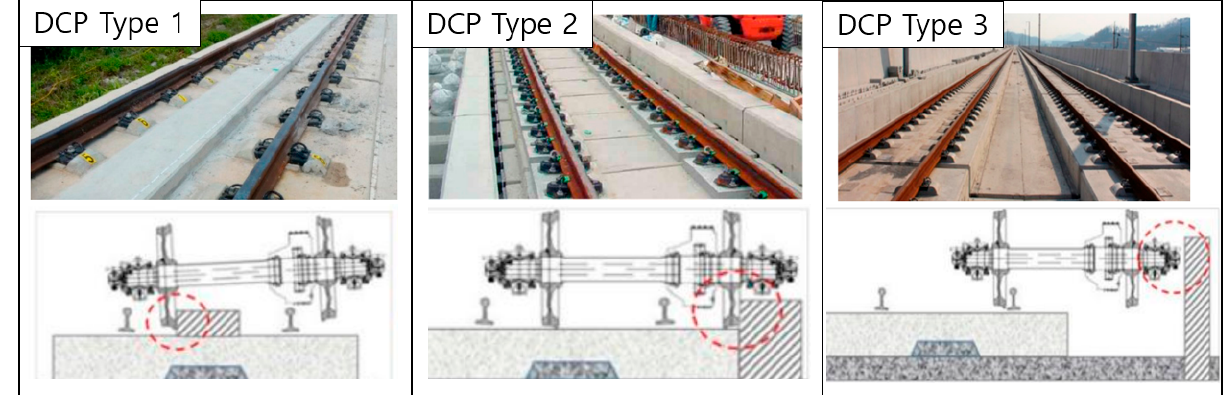
Figure 3. Various types of DCP.